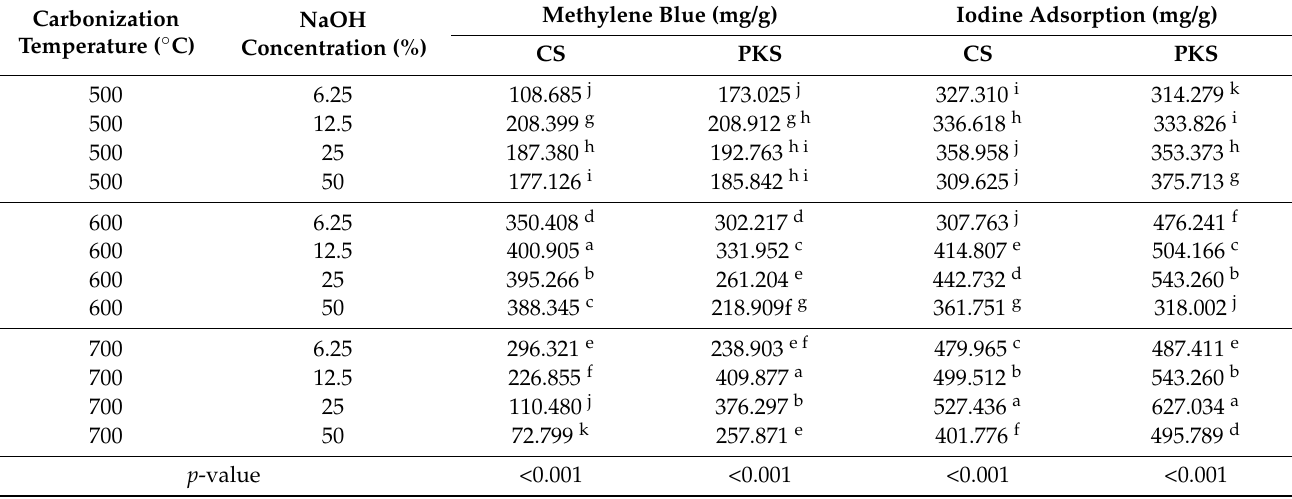
Table 3. ANOVA for adsorption properties of activated